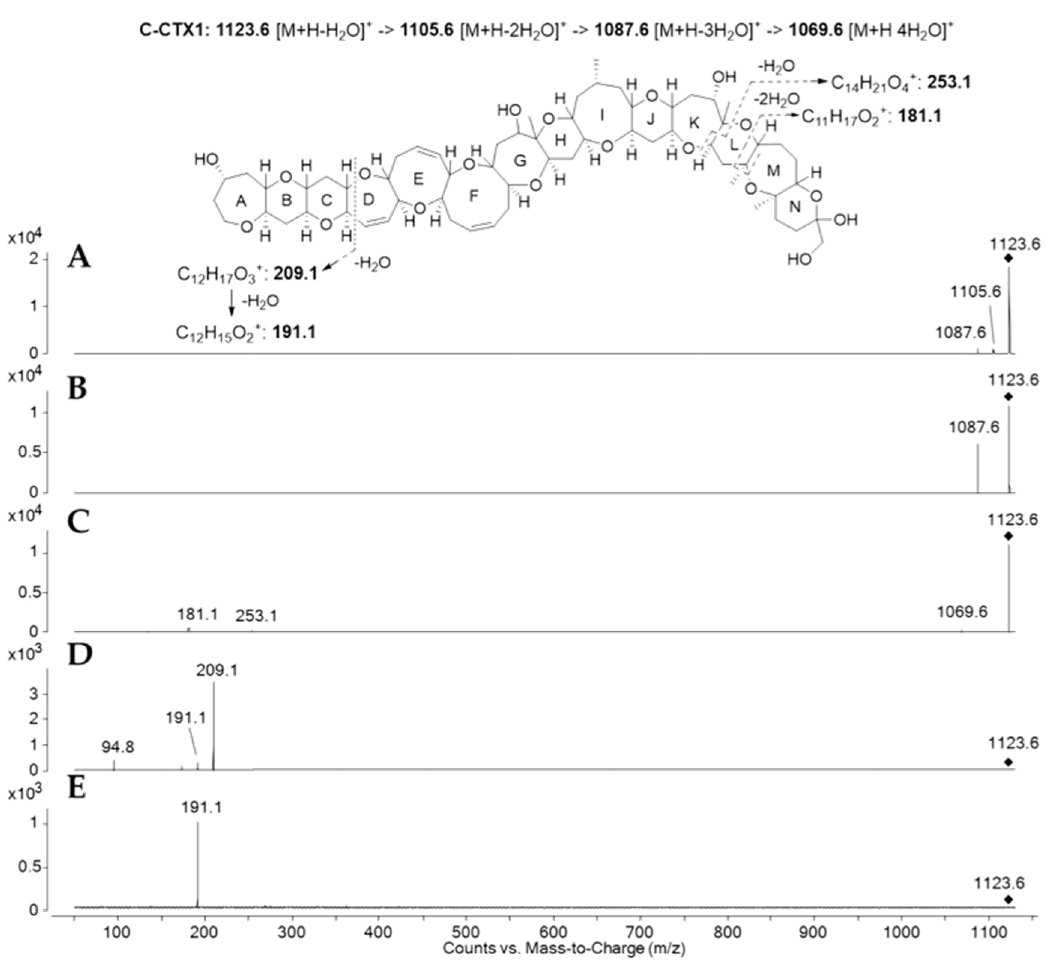
Figure 7. MS/MS spectra of C-CTX1 purified reference material selecting m / z 1123.6 [M+H-H 2 O] + as precursor ion and fragmented at different collision energies: ( A ) 25 eV; ( B ) 30 eV; ( C ) 40 eV; ( D ) 45 eV; ( E ) 50 eV. Table 2. Relative Molar Response (RMR) and concentration (fM) of the CTXs evaluated in this work. CTX1B C-CTX1 CTX3C Concentration (fM) 4.5 4.4 4.9 Peak area 21.375 10.116 23.614 RMR 1.0 0.5